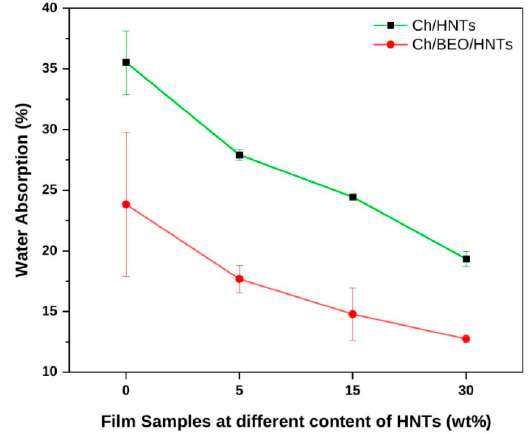
Figure 4. Water absorption of Ch films formulated with HNTs and BEO.